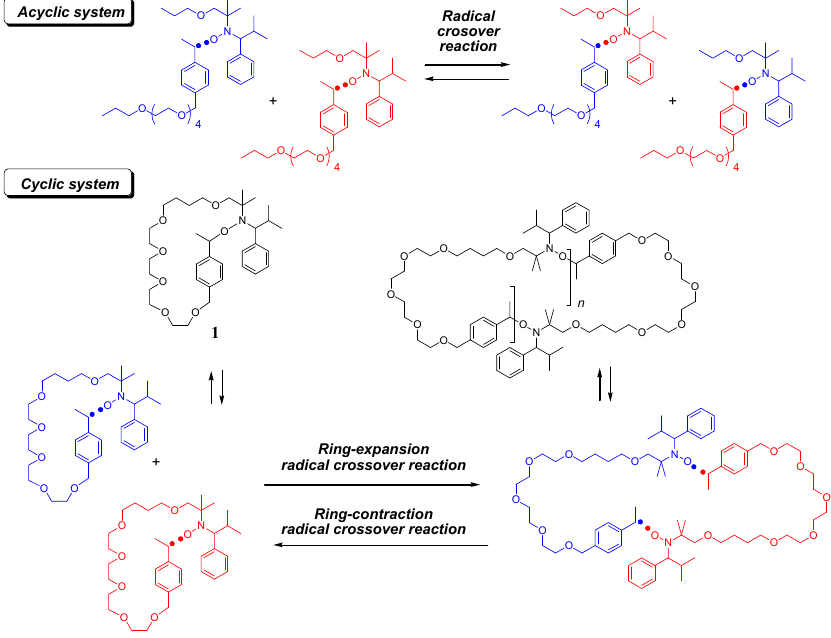
Scheme 2. Radical crossover reactions for the acyclic and cyclic